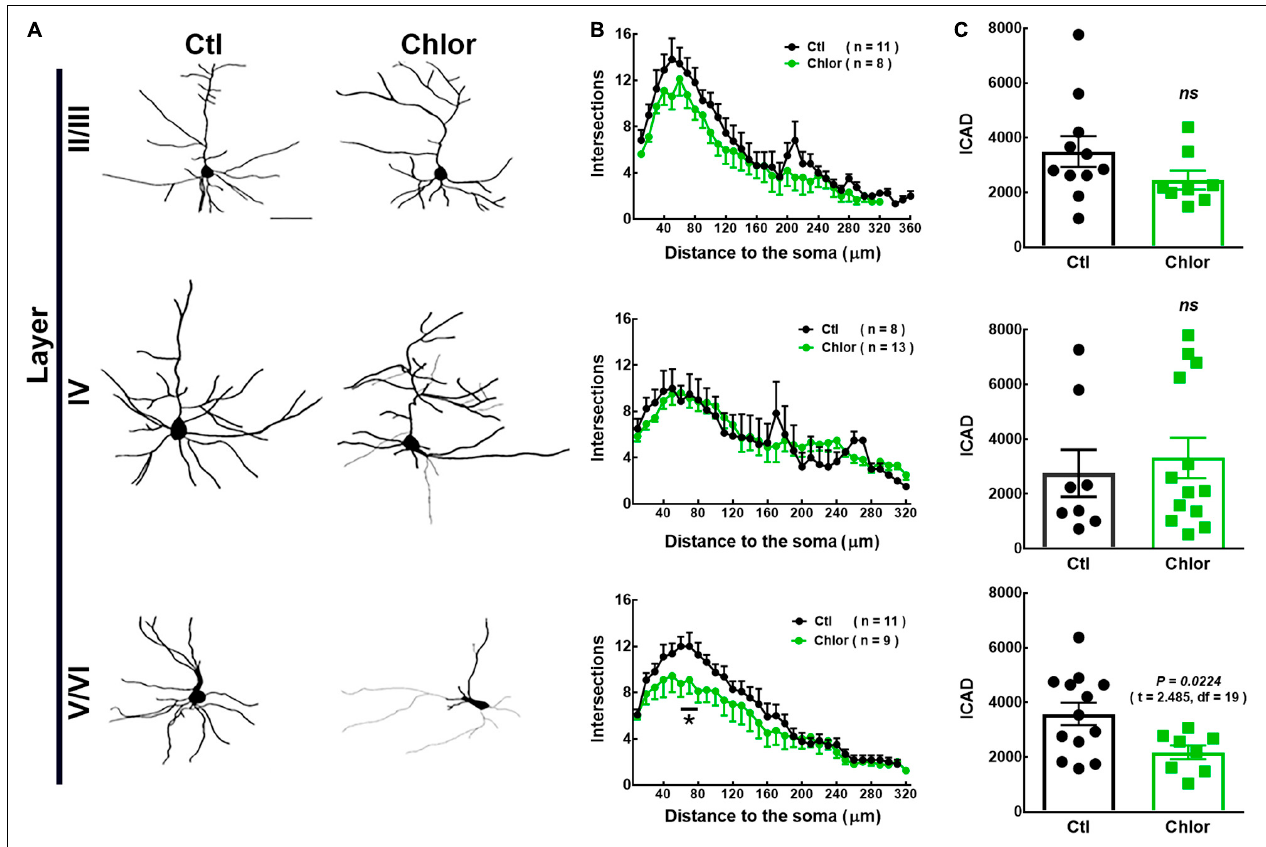
FIGURE 3 | Analysis of the dendritic arbor in 21-day-old offspring from control and chlorpheniramine-treated rats. (A) Representative reconstruction of Golgi-Cox-stained projection neurons in cortical layers I–VI. (B) Sholl analysis. Values are means ± SEM from the number of dendrite intersections with respect to the distance from the soma in Control (Ctl, black dots) and Chlorpheniramine (Chlor, green dots) groups. * P < 0.5 versus control values at ∼ 60 and ∼ 80 µ M; multiple t -test. (C) Analysis of the dendritic complexity index (DIC) of neurons obtained from the offspring of control (black bars) and chlorpheniramine (green bars) groups ( n = 3–4; P21). The statistical analysis was performed with unpaired Student’s t -test. ns, non-significant .